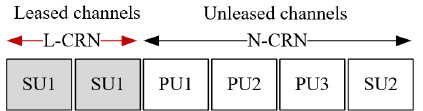
Figure 2. Channel assignment in the cognitive radio network